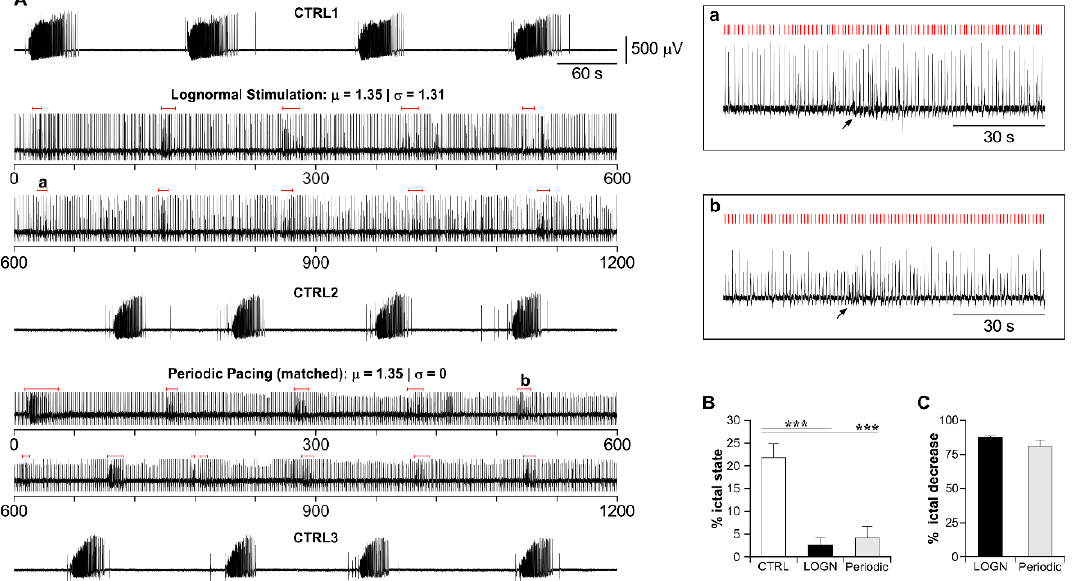
Figure 5. The surrogate lognormal pulse train is as effective as the matched periodic pacing protocol. ( A ) Representative experiment illustrating the effect of lognormal stimulation vs. its matched periodic pacing protocol (CTX recording). The signals for the stimulation protocols are the full 20-min session, split into two 10-min chunks for clarity. In this experiment, the CTX generated only short population bursts (red lines) during electrical stimulation. Ictal activity returned similar to the initial baseline condition (CTRL) after stimulus withdrawal. The boxed signals are the events marked by ( a ) and ( b ) in the stimulation sessions, visualized at a faster time scale. Stimulus times are indicated by the red bars. ( B ) Summary of the % of ictal state duration during CTRL (pooled data), lognormal and periodic stimulation. Both protocols significantly decrease the overall ictal state. ( C ) Comparison of the % of ictal state decrease of the lognormal and matched periodic pacing paradigms vs. pooled CTRL data. The two stimulation protocols exhibit a statistically similar efficacy. *** p < 0.0001. Table 3. Effect of lognormal and matched periodic stimulation on ictal activity (dataset summarized in Figure 5). *** p < 0.0001.